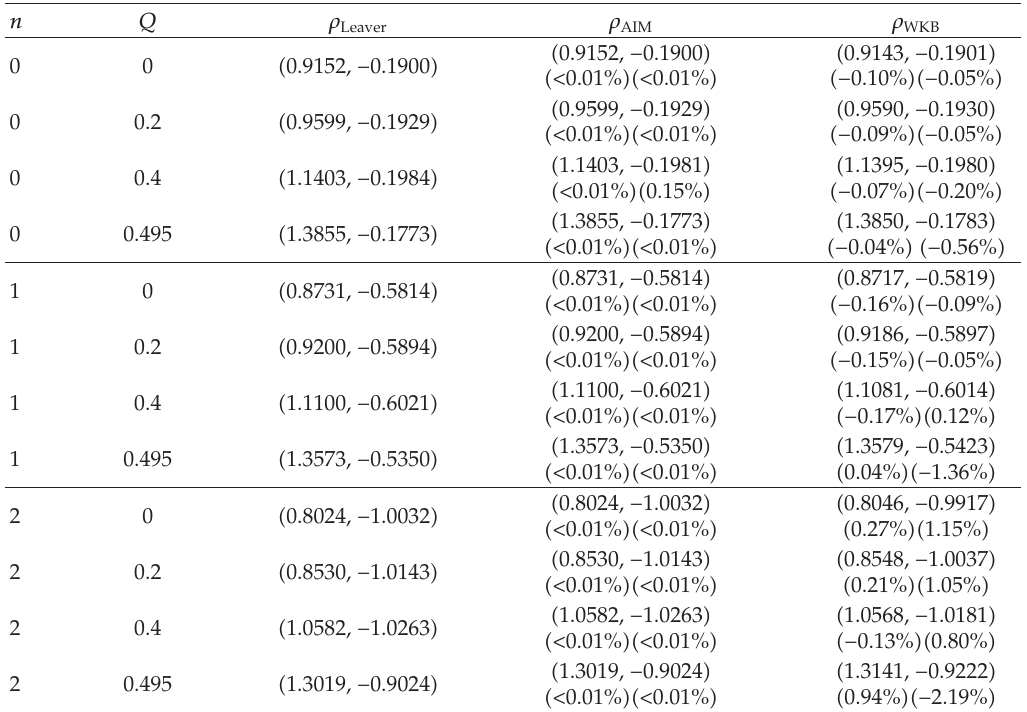
Table 5: Reissner-Nordstr¨om quasinormal frequency parameter values (cid:2) ρ (cid:8) − iω (cid:3) for the fundamental (cid:2) n (cid:8) 1 (cid:3) and two lowest overtones for l (cid:8) 2 and i (cid:8)